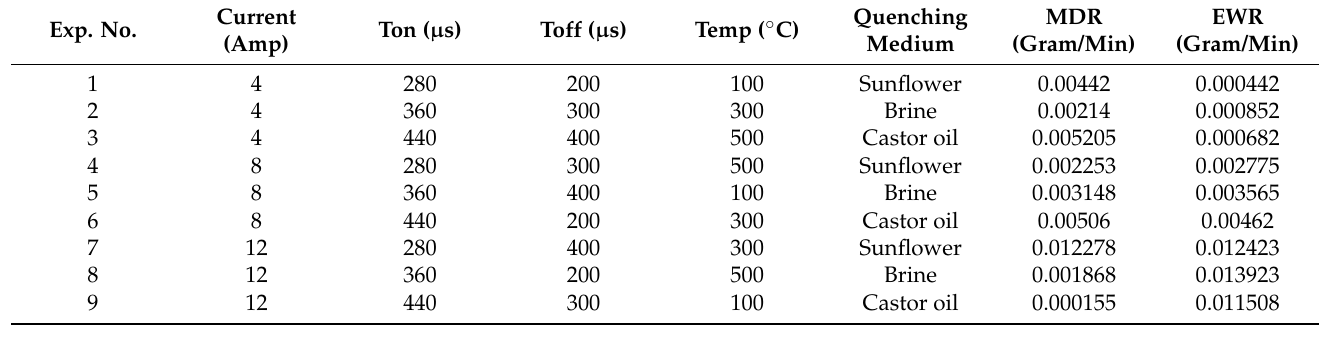
Table 3. Substrate Heating and Quenching and Experimental Data.